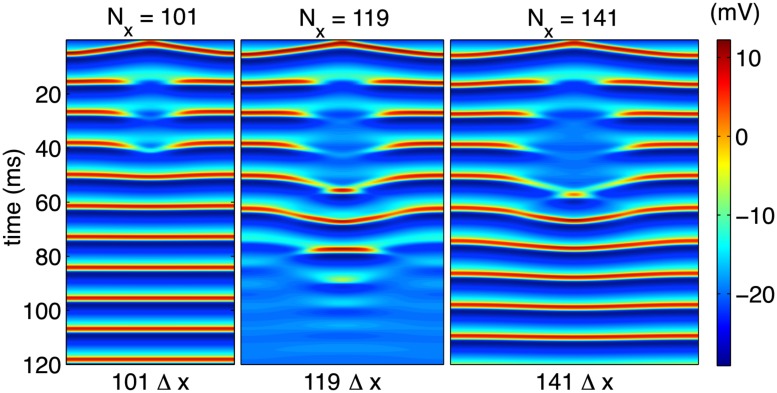
Larger stimulation current (i
0 = 800μA/cm2) is used for a shorter time (T
0 = 50Δt) in the middle of the cable.The modified stimulation protocol produces qualitatively similar results to those shown in Fig. 7